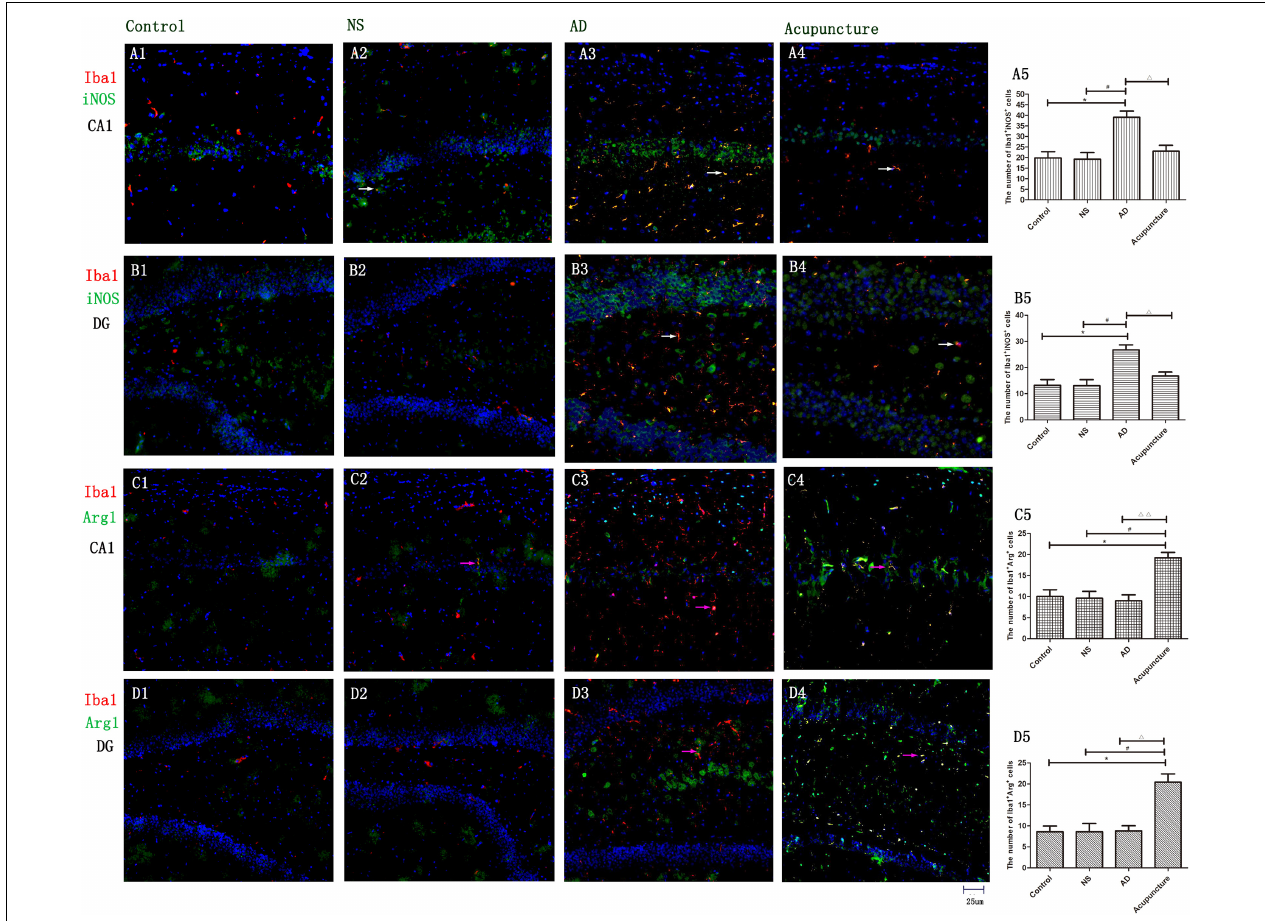
FIGURE 3 | The microglia polarization in different groups. (A1–4) Microglia of CA1 was double-stained with anti-iNOS and anti-Iba1 antibody and was observed on fluorescent image. (Red expresses Iba1-positive cells, green expresses iNOS-positive cells, and blue expresses DAPI. The white arrow expresses iNOS + Iba1 + cells.) (B1–4) Microglia of DG was double-stained with anti-iNOS and anti-Iba1 antibody and was observed on fluorescent image (Red expresses Iba1-positive cells, green expresses iNOS-positive cells, and blue expresses DAPI. The white arrow expresses iNOS + Iba1 + cells.) (C1–4) Microglia of CA1 was double-stained with anti-Arg1 and anti-Iba1 antibody and was observed on fluorescent image. (Red expresses Iba1-positive cells, green expresses Arg1-positive cells, and blue expresses DAPI. The pink arrow expresses iNOS + Iba1 + cells.) (D1–4) Microglia of DG was double-stained with anti-Arg1 and anti-Iba1 antibody and was observed on fluorescent image (Red expresses Iba1-positive cells, green expresses Arg1-positive cells, and blue expresses DAPI. The pink arrow expresses iNOS + Iba1 + cells.) (A5,B5,C5,D5) The number of positive stained cells in four groups. Error bars: SE. Compared with Control group, * p < 0.05; compared with NS group, # p < 0.05; compared with AD group, (cid:77) p < 0.05, (cid:77)(cid:77) p < 0.01 ( n =